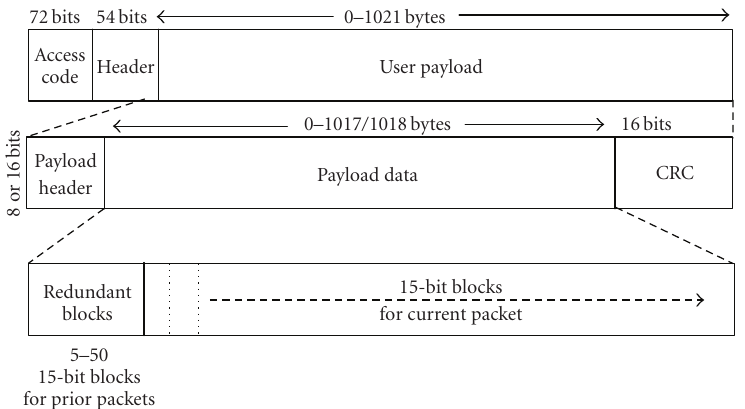
Figure 2: Bluetooth packetisation structure, showing the incorporation of redundant blocks into the payload.